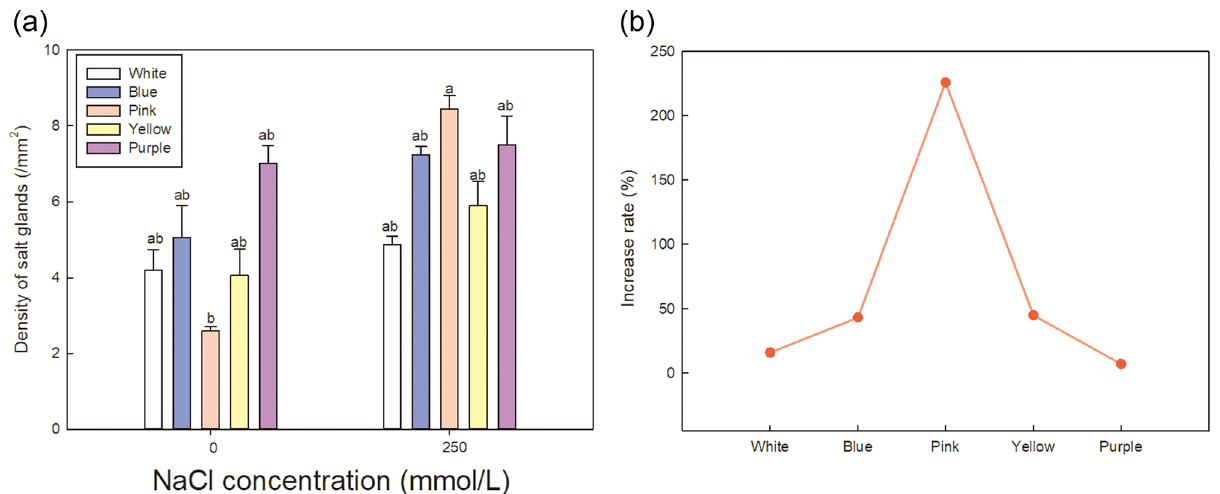
Figure 9. Effect of NaCl stress on salt gland density in the leaves of five varieties of Limonium sinuatum . ( a ) The data are means ± SD of five replicates. Different letters indicate significant differences between two groups at P = 0.05 using Duncan’s with SPSS. ( b ) The increase rate of salt gland density was calculated using (value under NaCl treatment—value under control)/value under control ×